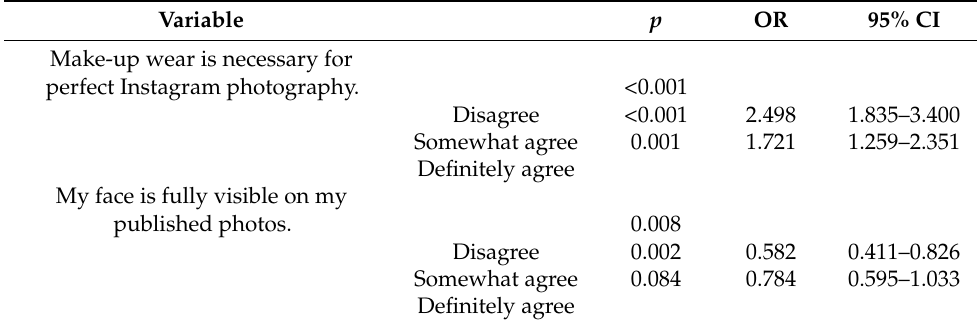
Table 8. Multinomial logistic regression analysis of association between respondent’s Instagram habits and preferences and augmentation scores. Variable p OR 95% CI Make-up wear is necessary for perfect Instagram photography. <0.001